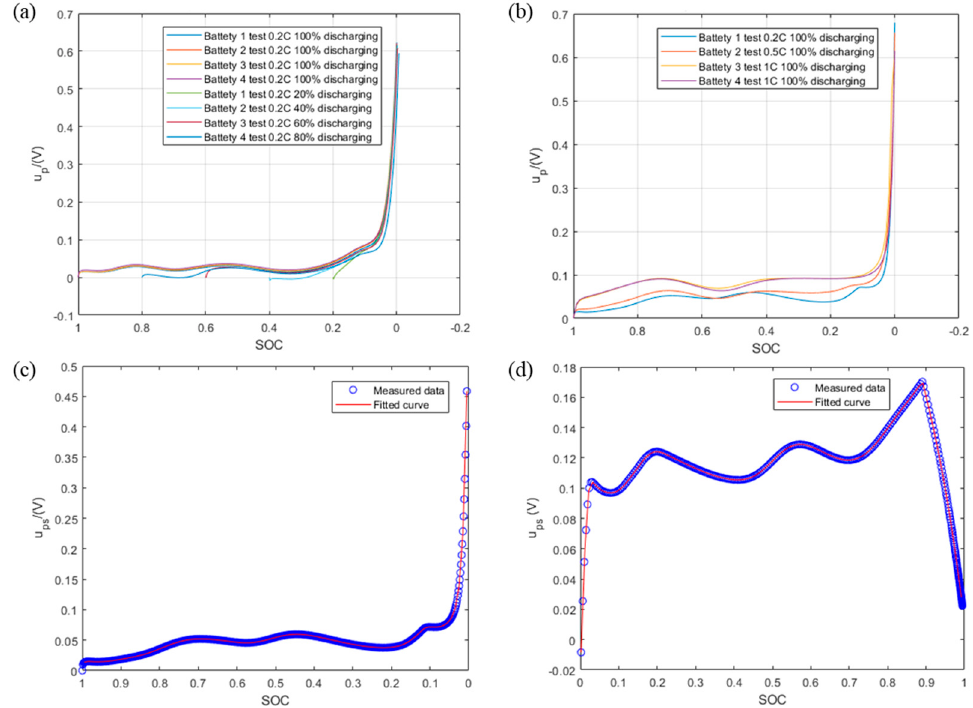
Figure 2. The polarization voltage ( u p ) SOC curves of discharging processes and the standard polarization voltage curves (25 ℃ ). ( a ) With different starting SOC points, ( b ) with different discharging current rates, ( c ) u ps for discharging process, and ( d ) u ps for charging process.